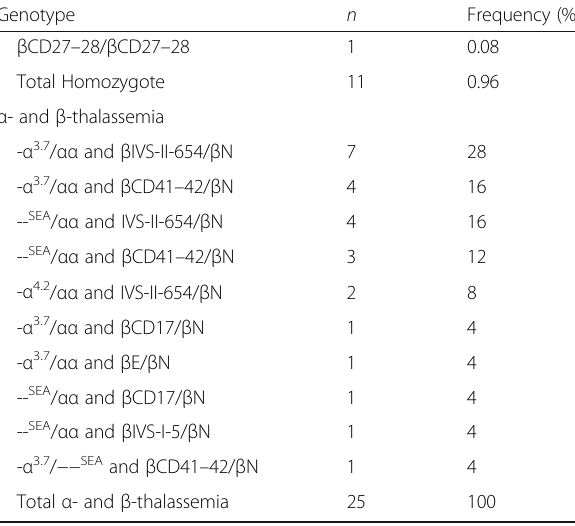
Table 1 Genotype, number of subjects and frequency